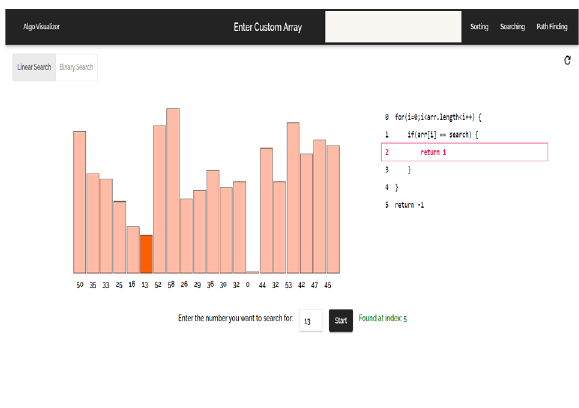
Fig.5. Linear Search Animation